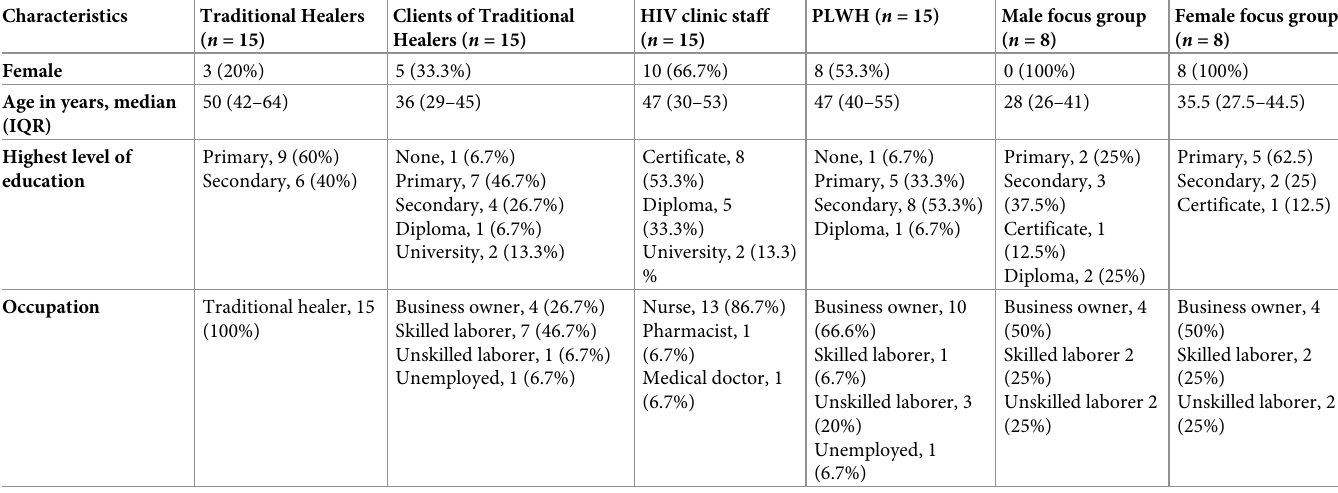
Table 1. Summary characteristics of study